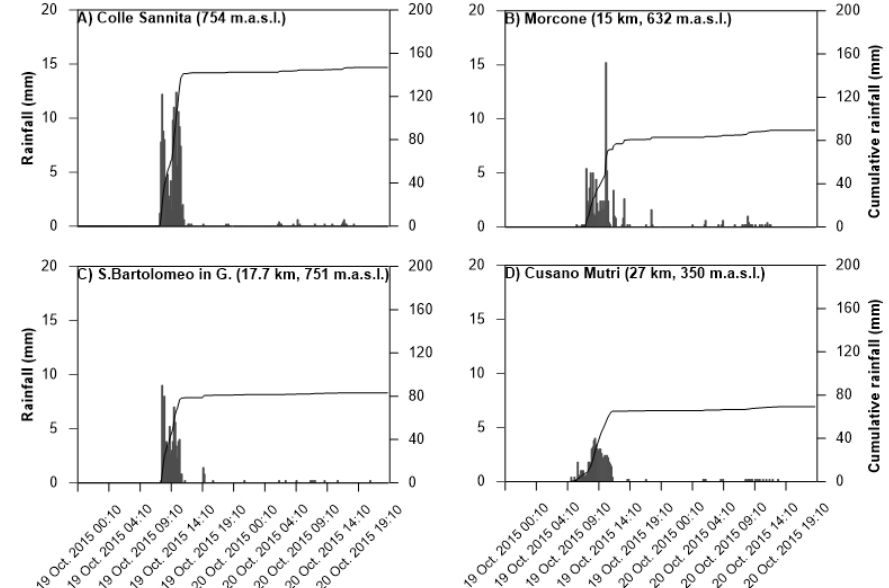
Figure 4. Ten-minute and cumulative rainfall for the event on 19–20 October 2015 recorded by some significant stations, starting from the maximum peak of intensity (Colle Sannita). See Figure 2 for station